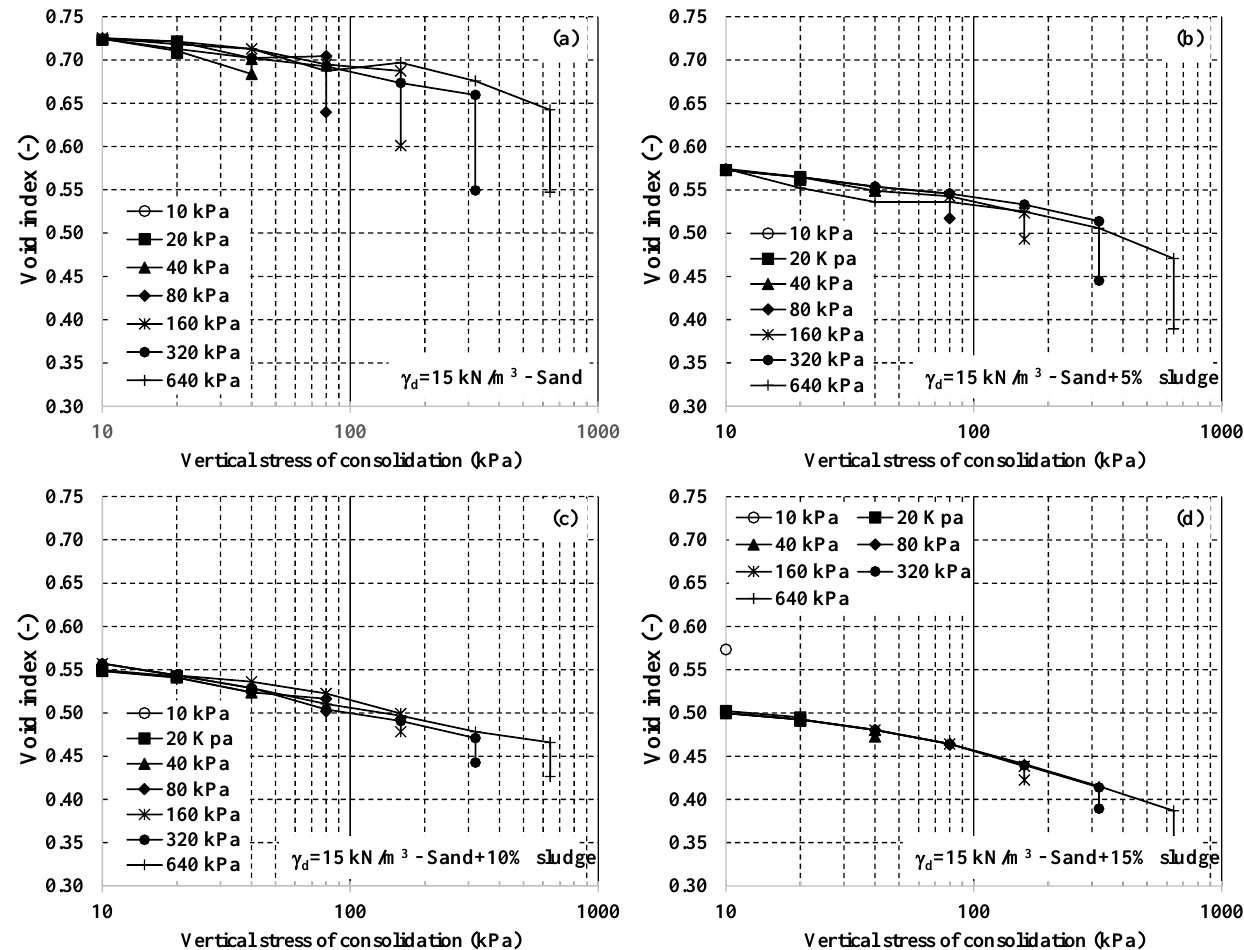
Figure 6. Variation of the void index with the vertical stress of consolidation obtained through single oedometer tests, for dry apparent specific weight of 15.0 kN/m 3 : ( a ) sand, ( b ) sand plus 5% sewage sludge, ( c ) sand plus 10% sludge, ( d ) sand plus 15% sludge. The results showed that for the soil without sludge and for a dry apparent specific weight of 15.0 kN/m 3 , the collapse increased reaching a maximum value of 6.61% at a stress of 320 kPa (critical stress for maximum collapse) and then it decreased. Soil compaction for the dry apparent specific weight of 17.0 kN/m 3 significantly reduced the collapse potentials to the maximum values of 1.64% for the 640 kPa stress. The addition of sludge to the soil decreased the potential for collapse. For the dry apparent specific weight of 15.0 kN/m 3 and stress of 10 kPa, the mixtures with 10% and 15% of sludge presented a small expansion. Similar behavior was observed for the dry apparent specific weight of 17.0 kN/m 3 at the stresses of 10 kPa and 20 kPa, for mixtures with 10% and 15% of sludge. This experimental campaign showed that the addition of sewage sludge to the soil is an important factor in reducing soil collapsibility. Similar behavior was observed with the increase in the dry apparent specific weight. For example, in the case of the dry apparent specific weight of 15.0 kN/m 3 , the decrease in collapsibility of the mixtures with 5%, 10%, and 15%, compared to the natural soil was 6.2%, 51.6%, and 56.4%, respectively. Similar results were found by Atarodi [36] when adding 0%, 2%, 4%, and 8% of sewage sludge ash and sewage sludge/lime ash to the collapsible soil of Iran. Sewage sludge samples collected from the Ikbatan wastewater treatment plant, in Tehran, were added to the collapsible soil causing reduced soil cohesion and a decreased internal friction angle φ